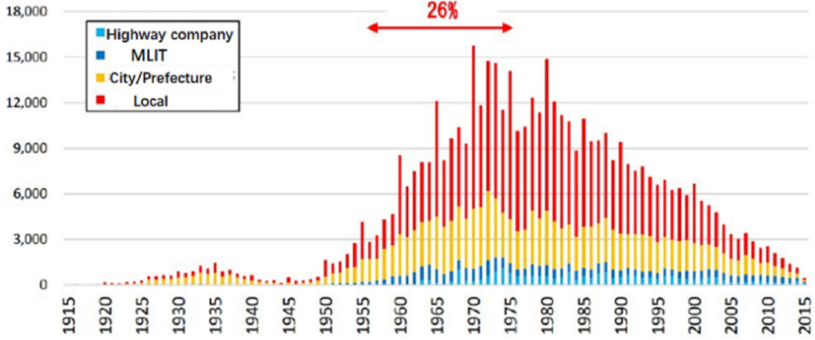
Figure 2. Bridges built in Japan by year (MLIT is the Ministry of Lands, Infrastructure, Transporta- tion, and Tourism).